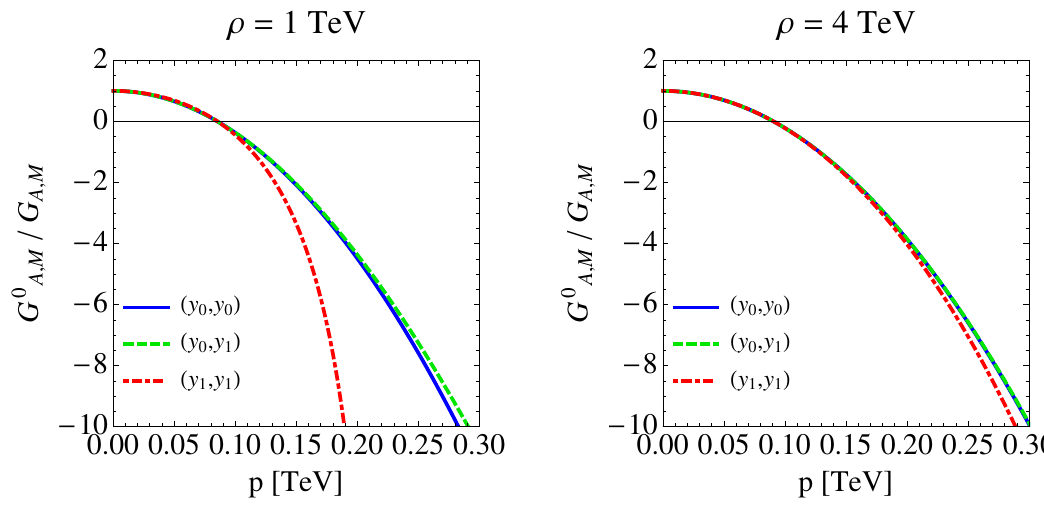
Figure 13 . Inverse ( y 0 , y 0 ) , ( y 0 , y 1 ) and ( y 1 , y 1 ) Green’s functions for A = Z , m Z = 0 . 091 TeV. They are normalized by their values in p = 0 . We display the results for ρ = 1 TeV (left panel) and ρ = 4 TeV (right panel). We have used A 1 = 35